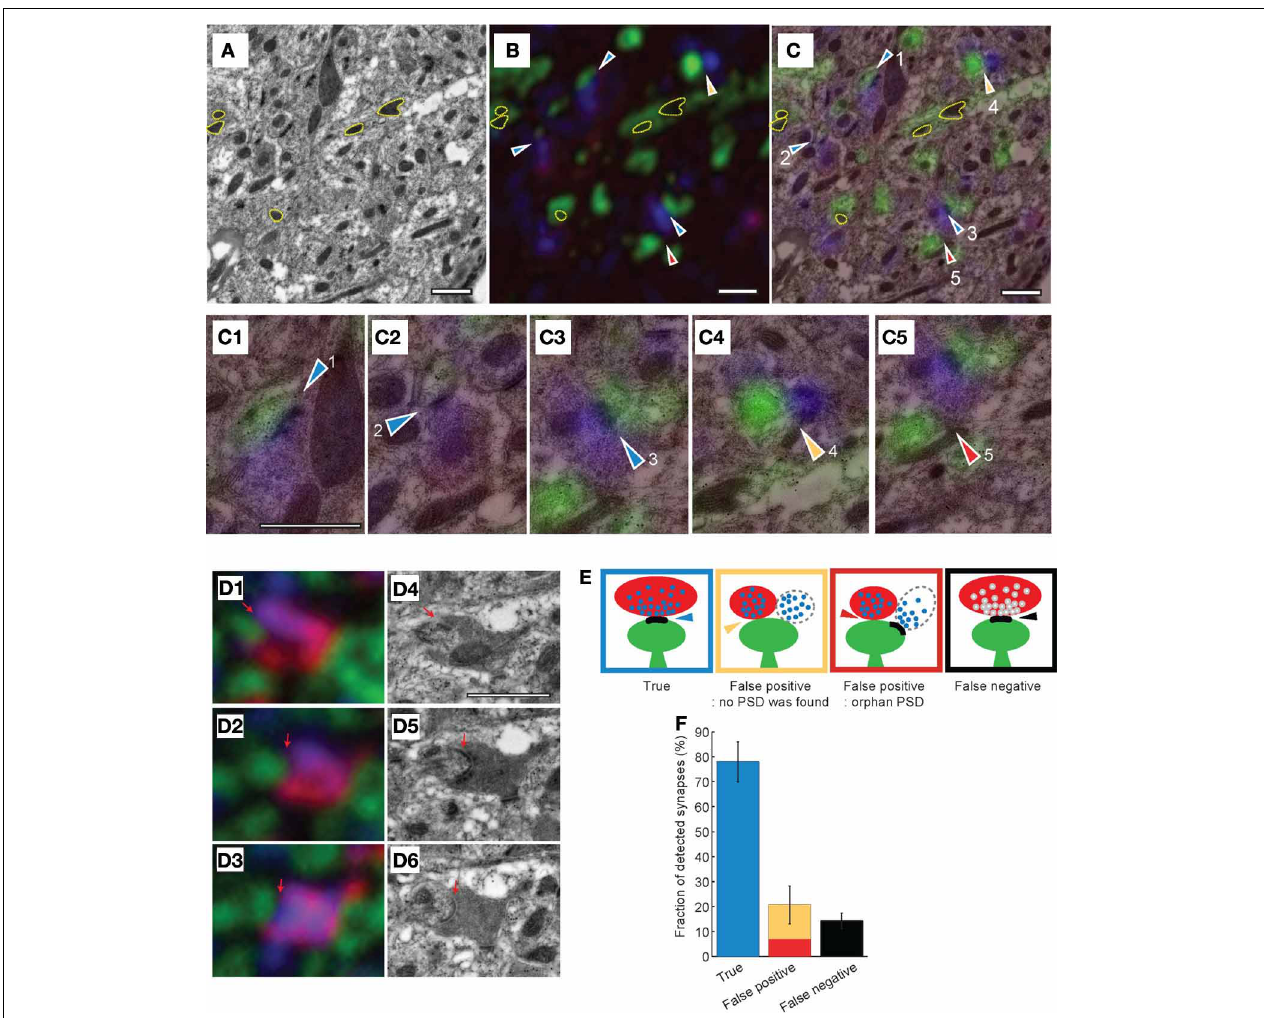
FIGURE 6 | Combined electron and light microscopy to determine the accuracy of synapse detection by array tomography. (A–C) Transmission EM (A) and light microscopy (B) images from the same section of tissue, and the two images superimposed (C) . Yellow contours in all three images show mitochondria that are used as fiducial markers for aligning images. Arrowheads indicate predicted TC synapses based on the light microscopic image, colors of arrowheads show true-false evaluation based on the EM image (as depicted in (D) . (C1–C5) Close up images of TC synapses